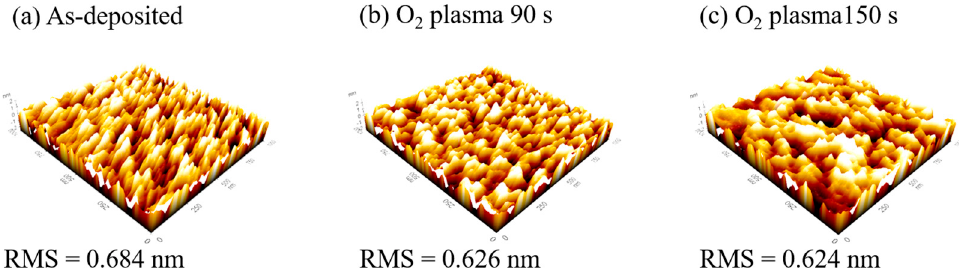
Figure 7. AFM images of the Zn 0.6 Sn 0.4 O thin films post O 2 plasma treatment. ( a ) as-deposited, ( b ) 90 s and ( c ) 150 s.